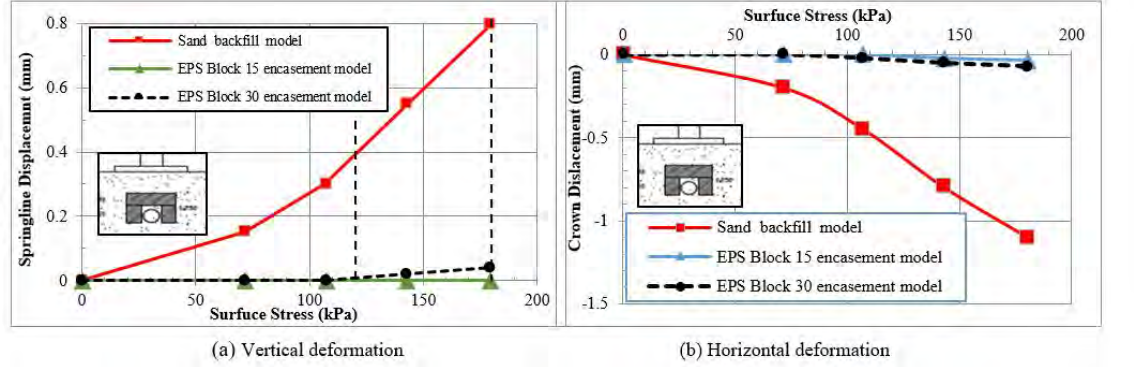
Figure 9. Deformation of UPVC buried pipe under embedded EPS encasement blocks